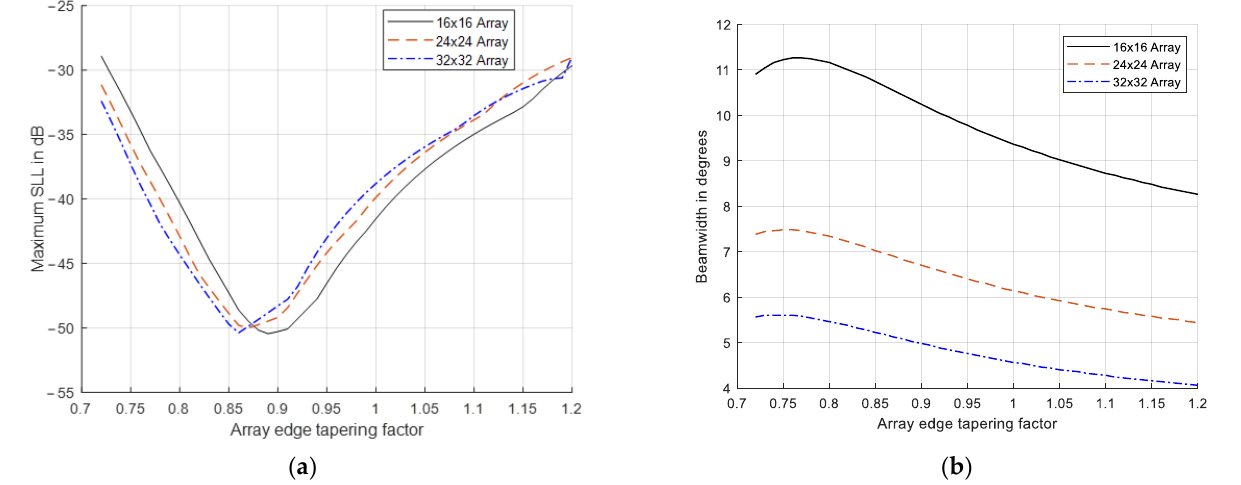
Figure 11. ( a ) Optimizing radial tapered Blackman window at different array sizes. ( b ) Beamwidth variation with the array edge tapering factor at different array sizes.